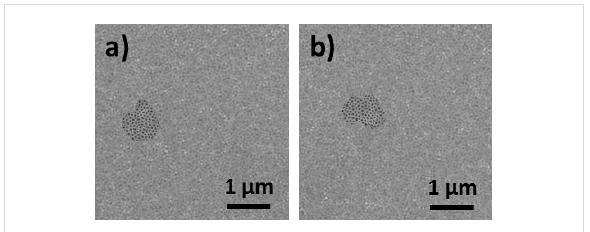
Figure 3: SEM micrographs of a) Au20NC and b) Au50NC .